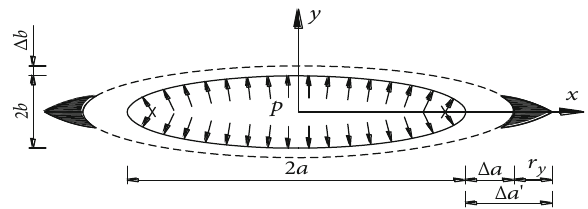
Figure 1: The microcrack propagation model under the frost heaving pressure. 2 a and 2 b are the length and width of the microcrack, respectively. △ a and △ b are the propagation length of the microcrack along two directions, respectively. r of the plastic zone near the microcrack tip. △ a ′ is the equivalent propagation length of the